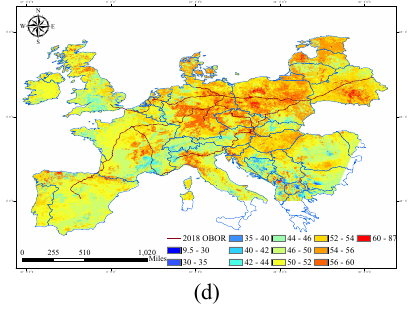
Fig 6. The difference maps of PM2.5, LST and NDVI during 2016 to 2018 in the study